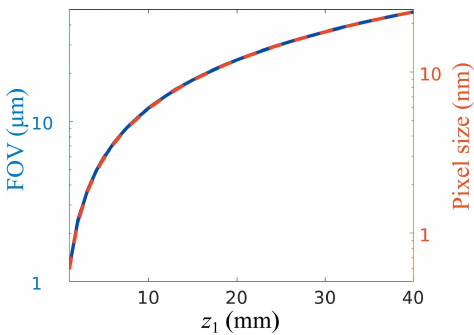
Figure 3 Field of view (FOV) and effective pixel size as a function of the defocusing distance ( z 1 ) for the NanoMAX in-line holography